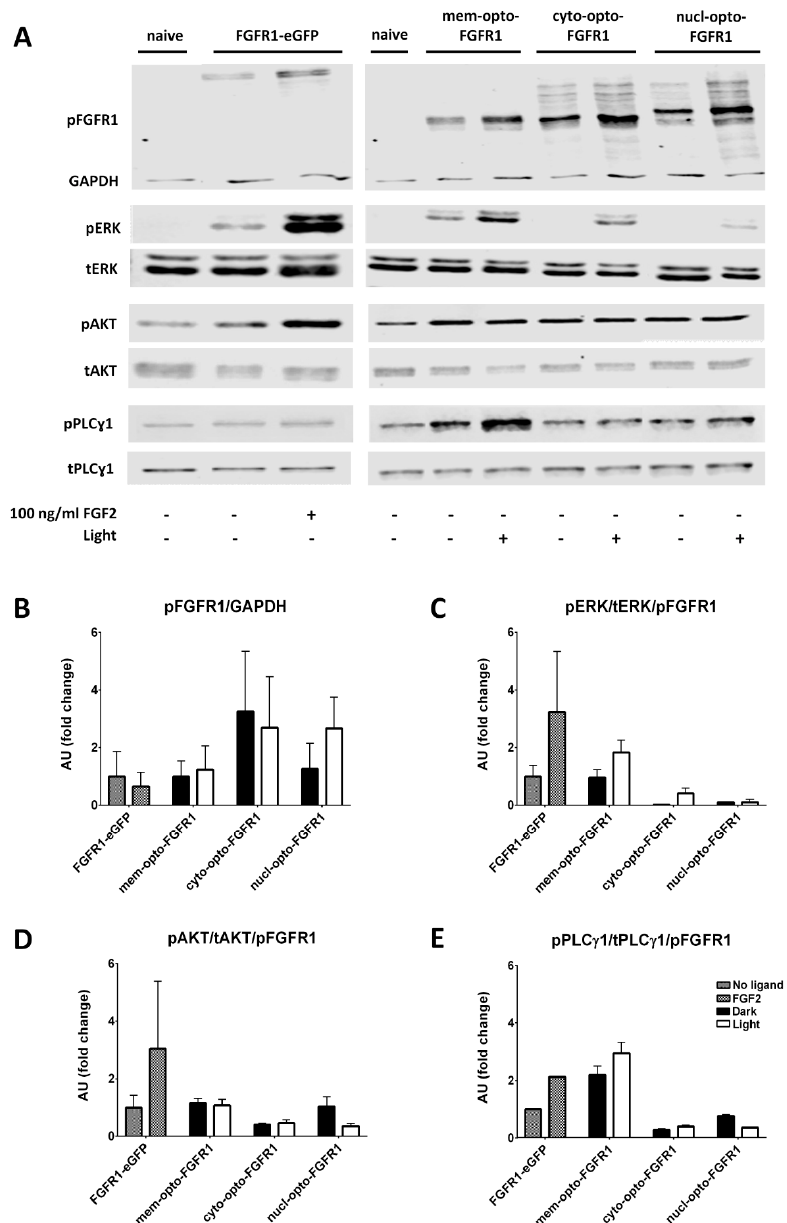
Figure 3. Immunoblot analysis of light- and FGF2-induced activation of key signaling molecules in HEK293 cells. ( A ) Representative examples of Western blots for pFGFR1/GAPDH, pERK/tERK, pAKT/tAKT and pPLC ɣ 1/ tPLC ɣ 1 are shown. ( B – E ) Average intensities of ERK, AKT, and PLC ɣ 1 phosphorylation were quantified after normalization for pFGFR1/GAPDH to control for differences in plasmid expression levels. All ratios are relative to FGFR1–eGFP (=1) and calculated from three independent experiments (mean ± SEM).